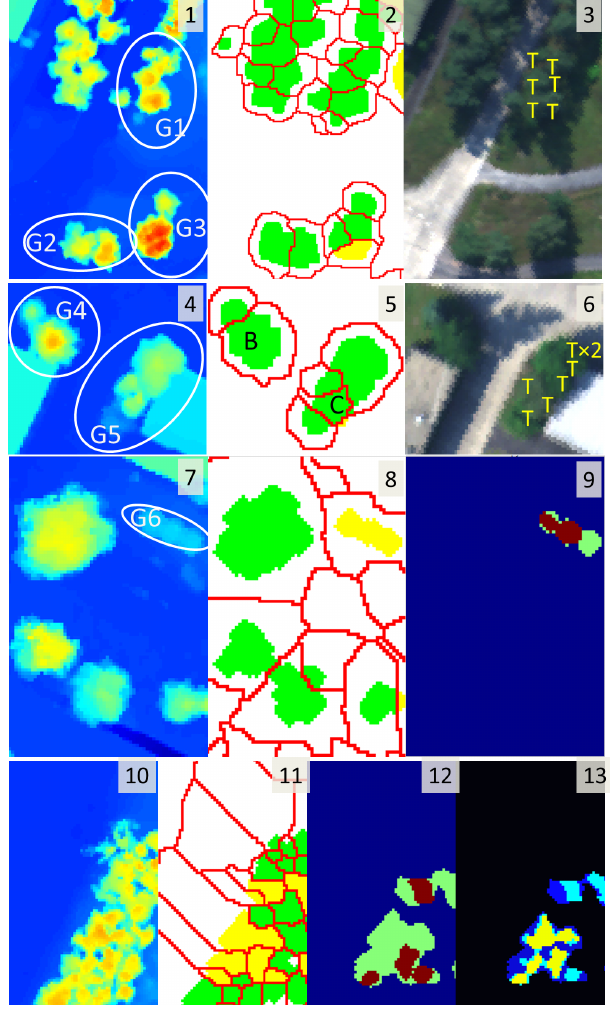
Figure 3: Detection of individual trees for four subsets of the dataset Meppen . The corresponding fragments of DSM and wa- tershed components are shown in images in the first two columns while the corresponding fragments of the orthophoto are pre- sented together with the approximate tree positions in images 3, 6. The watershed components are separated from each other by red lines. The green and yellow components demonstrate, respec- tively, the tree-like and non-tree-like intersections of classifica- tion results and watershed components. The large non-tree-like regions are subject to hotspots detection (images 9 and 11), of which tree-like and non-tree-like hotspots are shown in red and green colors, respectively. Image 13 shows the nested compo- nents. Trees B and C in image 5 are examples used in